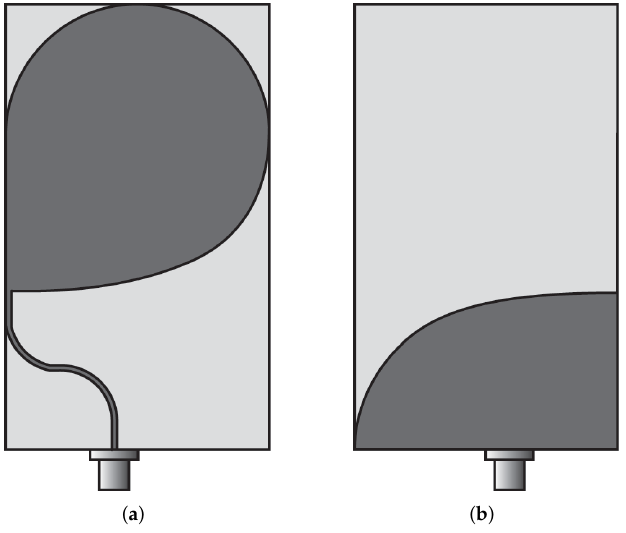
Figure 14. Half-heart shaped planar antenna to monitor cardiac activities ( a ) top metal ( b ) bottom metal (redrawn from [70]). Dark gray metal face and light gray dielectric substrate. Mahmud et al. [71] designed a Hibiscus petal pattern-like patch antenna for microwave imaging systems. A tapered microstrip feed line and a partial trapezoid ground plane